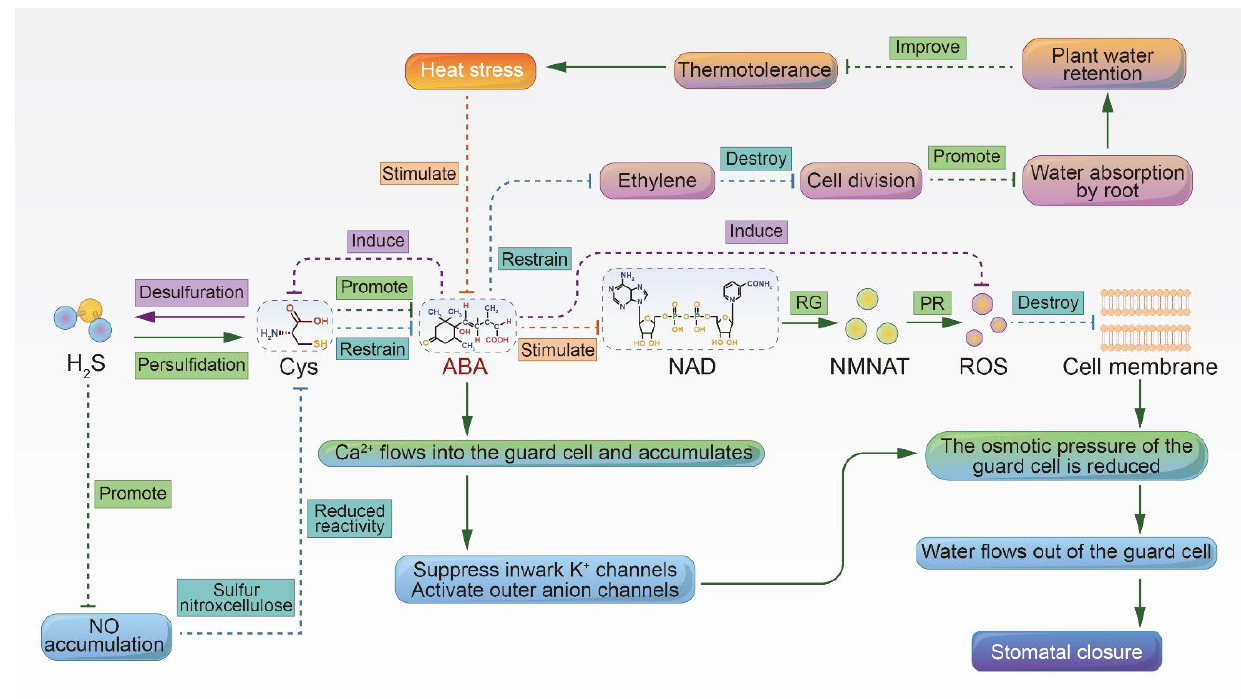
Figure 1. Diagram showing the mechanisms by which ABA improves heat resistance by inducing stomatal closure, promoting root growth and maintaining plant water status. ABA, abscisic acid; Cys, cysteine; H 2 S, hydrogen sulfide; NAD, nicotinamide adenine dinucleotide biosynthesis; NMNAT, nicotinate/nicotinamide mononucleotide adenyltransferase; NO, nitric oxide; PR, prevent; RG, regulate; ROS, reactive oxygen species.